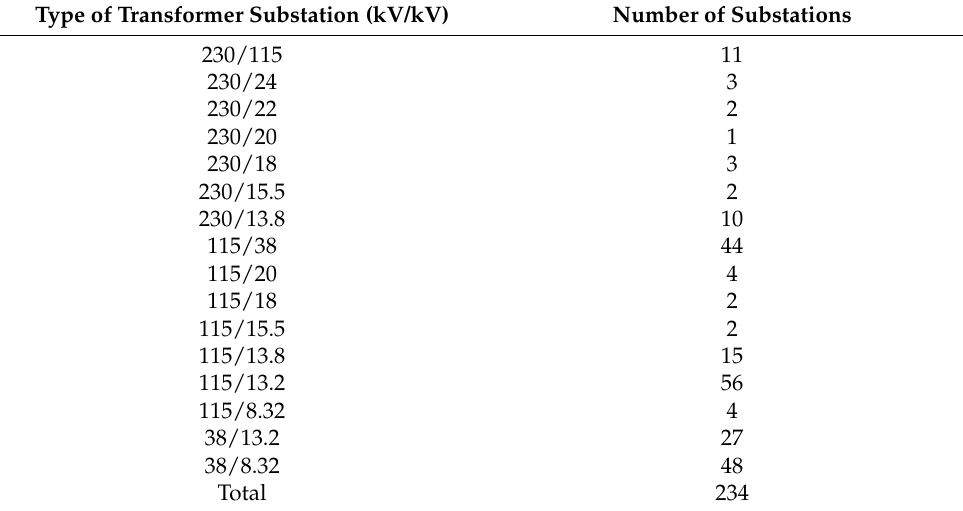
Table 10. Summary of the simulated transformer substations.